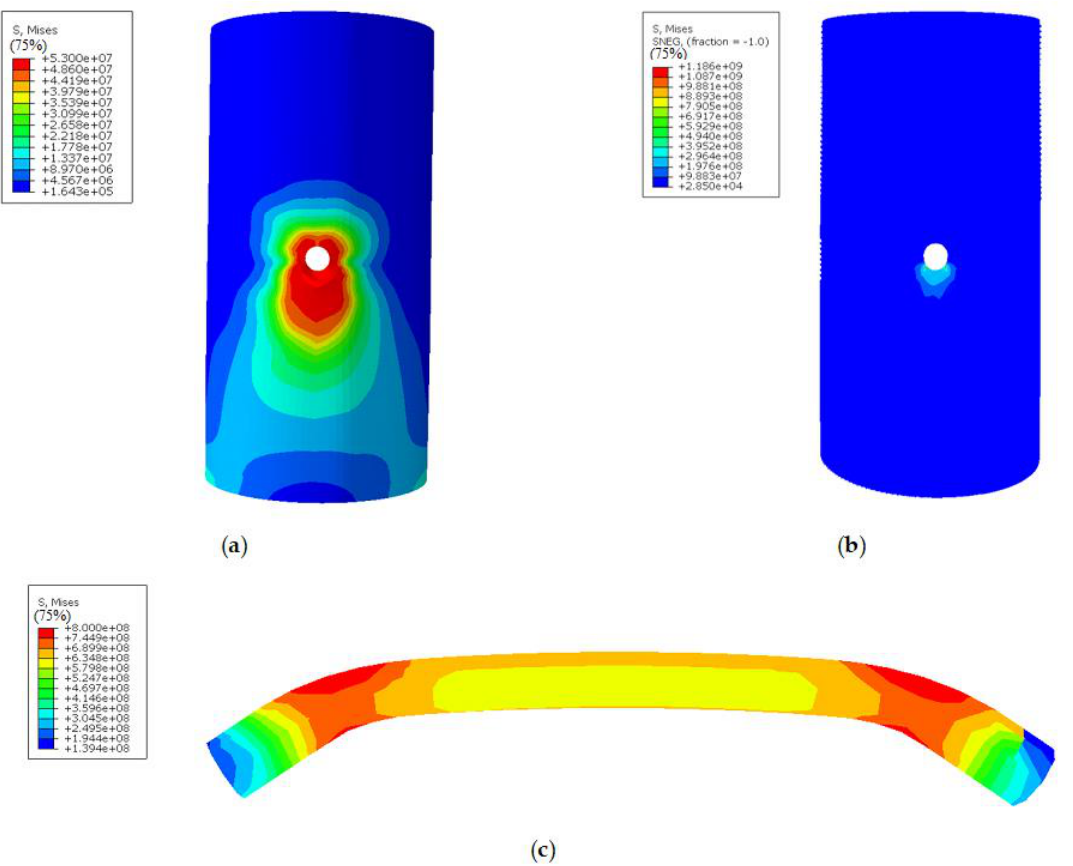
Figure 8. Stress nephogram of the components in the composite joint. ( a ) Stress nephogram of bamboo; ( b ) Stress nephogram of GFRP; ( c ) Stress nephogram of